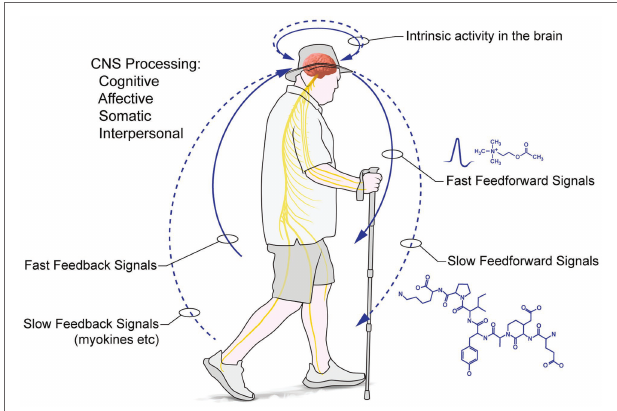
FIGURE 1 | Personal: PW entrains reciprocal, feedforward (brain → body), feedback (body → brain) and intrinsic (brain region → brain region) intrapersonal processes supporting and consolidating changes in brain and